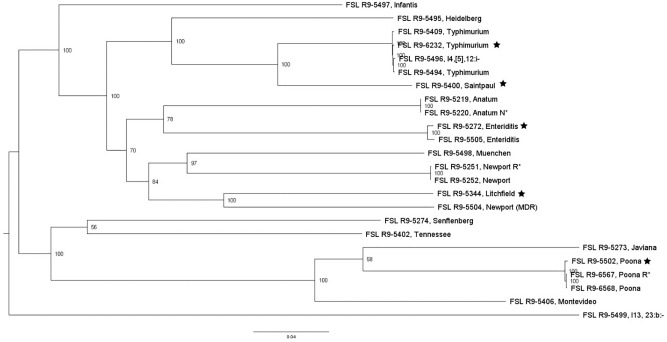
Salmonella maximum-likelihood tree based on core SNP analysis using kSNP. The phylogeny for strains was inferred using RAxML and tree was rooted by midpoint. The strain FSL ID is followed by serotype; R∗ and N∗ indicate rifampicin and nalidixic acid resistant strains, respectively. The node labels represent bootstrap values of 1000 repetitions. The bar indicates 0.04 substitutions per site. Strains marked with a star were selected as representative strains for phenotypic analyses (i.e., PAA experiments).